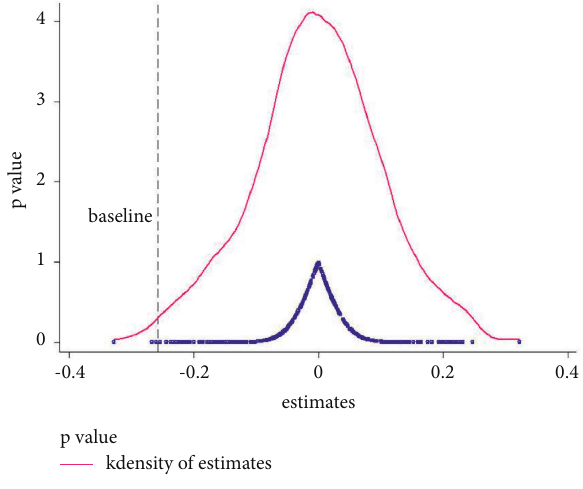
Figure 3: Placebo test